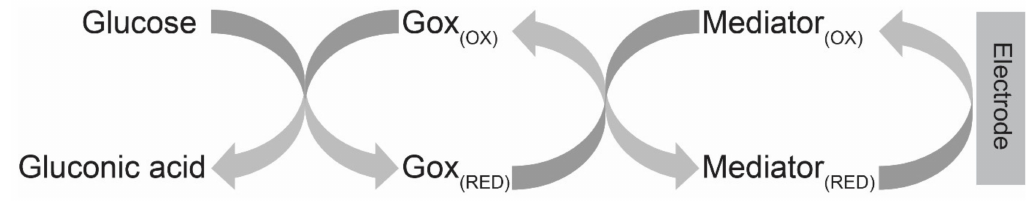
Figure 5. Principle of mediator-based enzymatic glucose